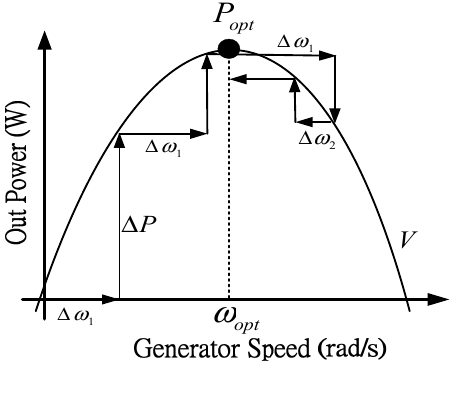
Figure 5. Curve of diagram hill-climbing search (HCS) on the characteristics of wind power.